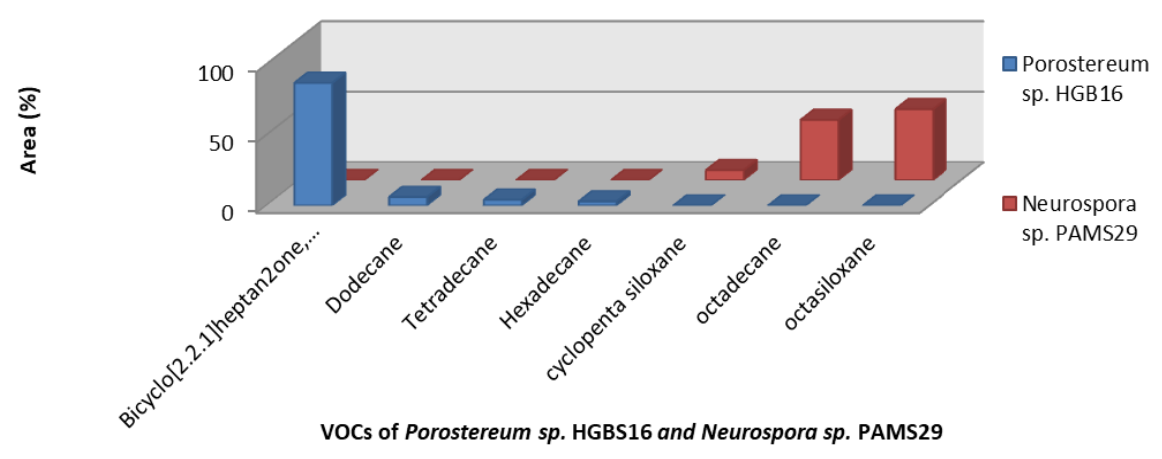
Figure 6. GCMS chromatogram of secondary metabolites produced by Porostereum sp. HGBS16 and